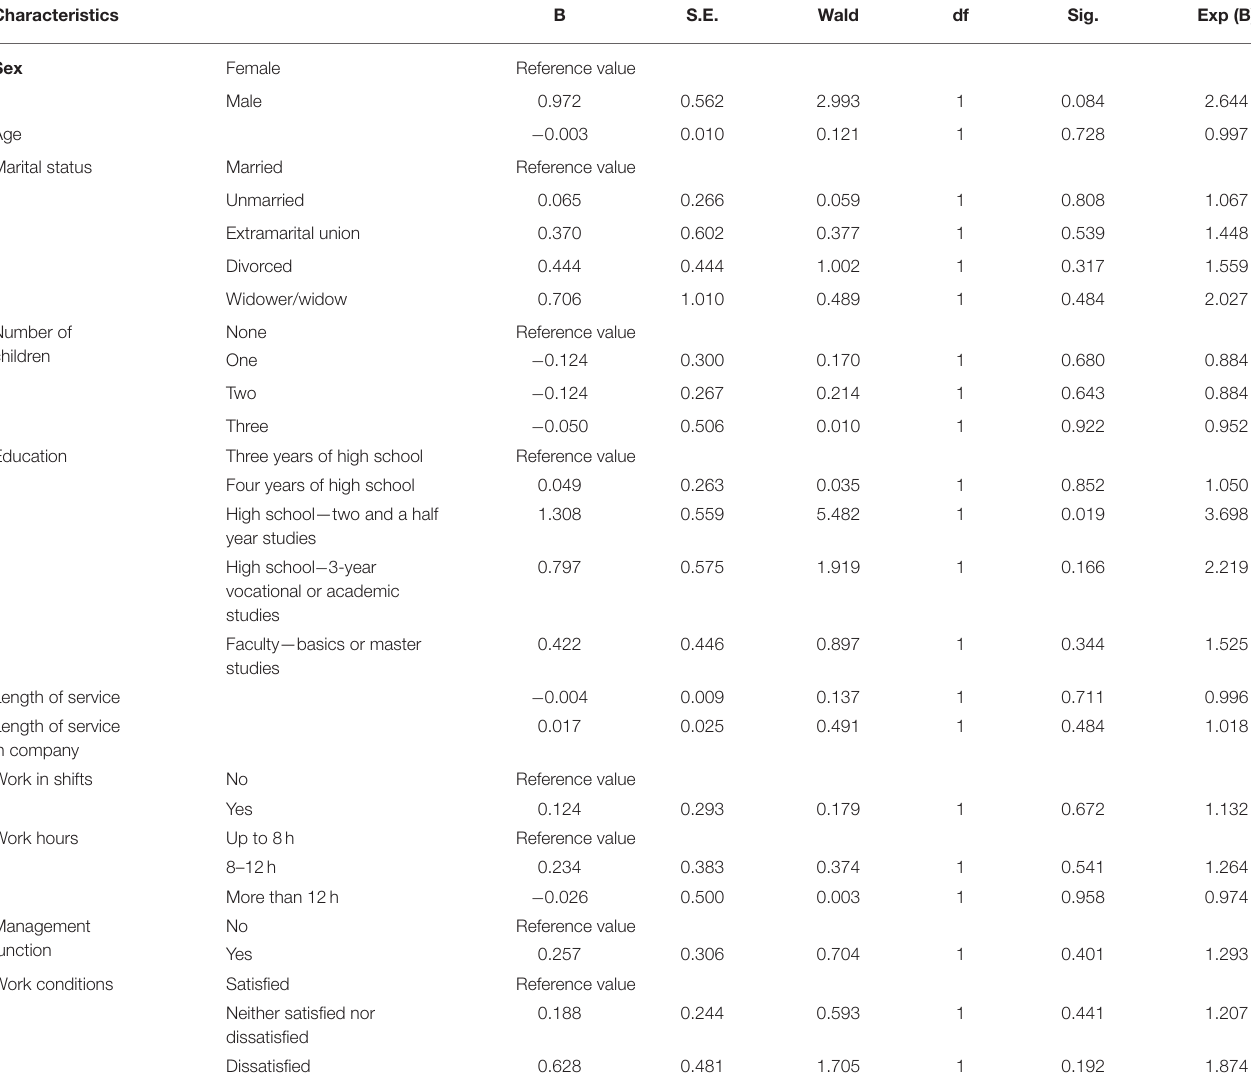
TABLE 6 | Factors affecting the PA variable: results of multiple regression analysis.